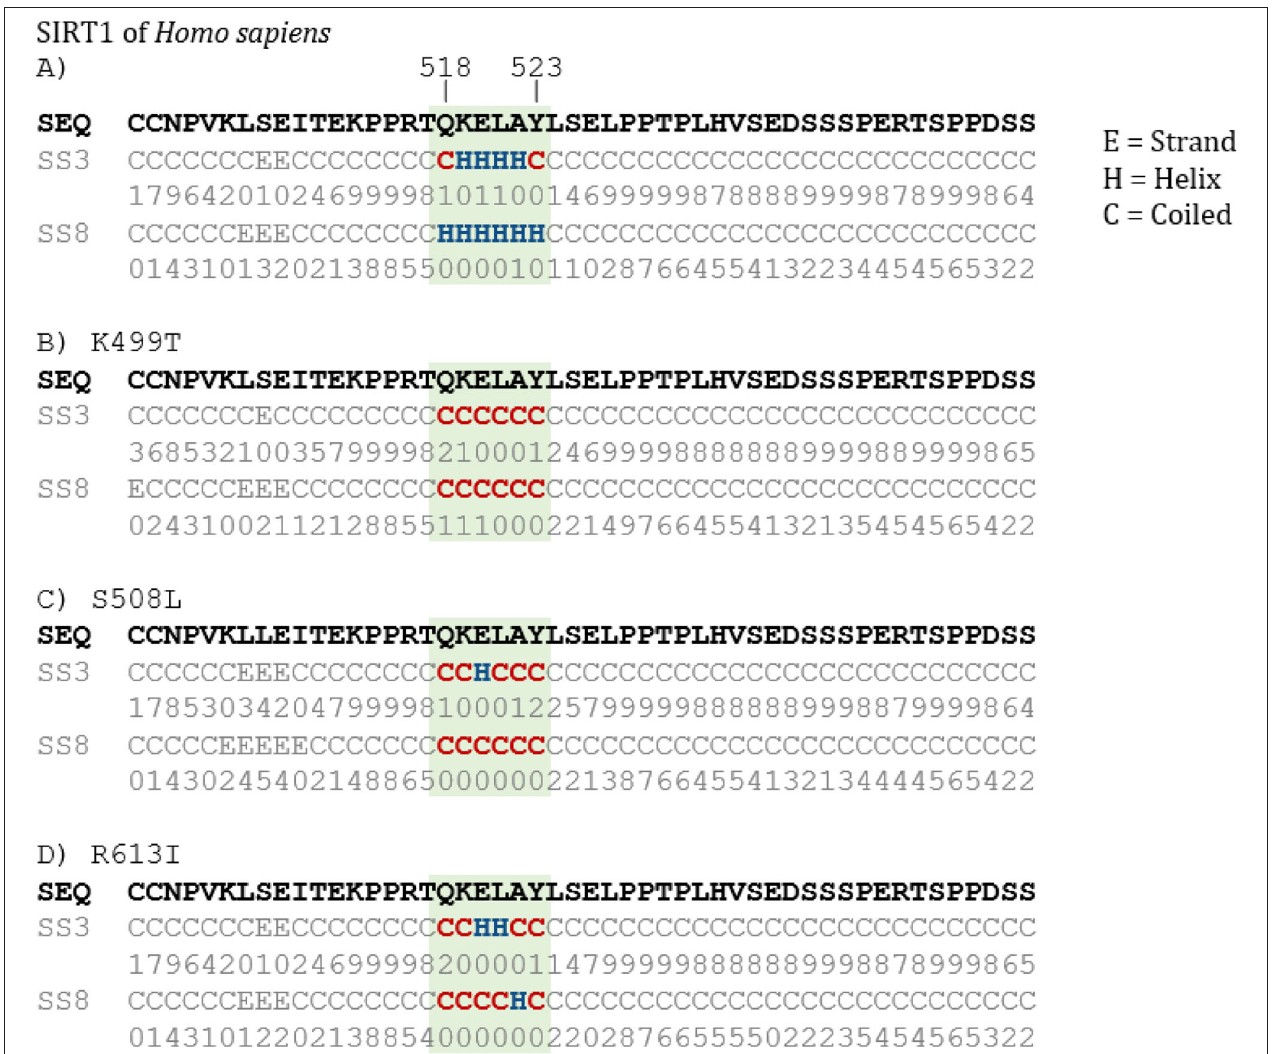
FIGURE 5 | Relevant section of secondary structure prediction. Protein sequences for secondary structure prediction are (A) human SIRT1 protein sequence, and human SIRT1 protein sequences with substitution of (B) lysin (K) to threonine (T) in amino acid site 499, (C) serine (S) to leucin (L) in amino acid site 508, (D) arginine (R) to isoleucine (I) in amino acid site 613. Predictions were performed with Porter 5.0 ( Torrisi et al., 2019). Secondary structures are divided into three classes: E, Strand; H, Helix; C, Coil; SS3, 3 class secondary structure; SS8, 8 class secondary structure, each followed by the line of confidence values for 3 and 8 class predictions, respectively (with 9, maximal confidence; 0, very little